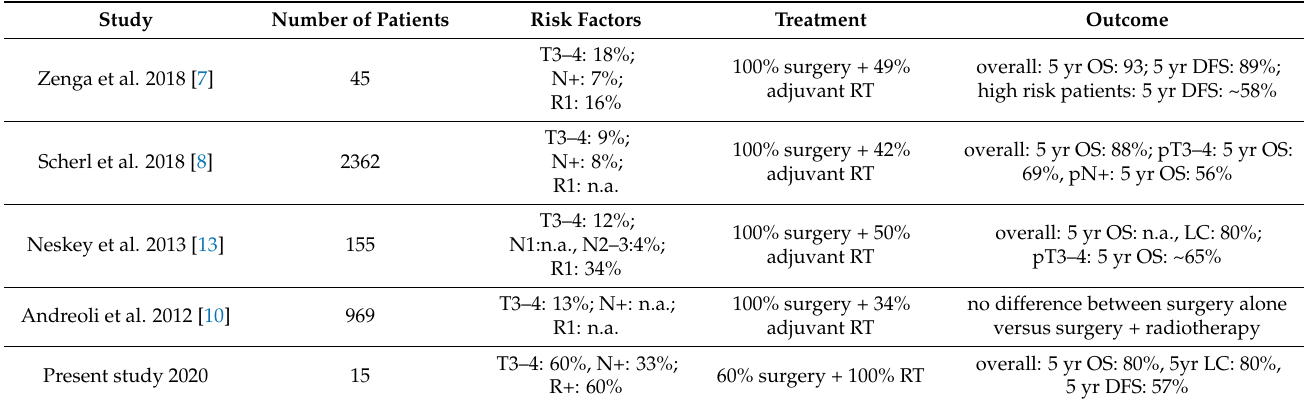
Table 4. Literature overview.